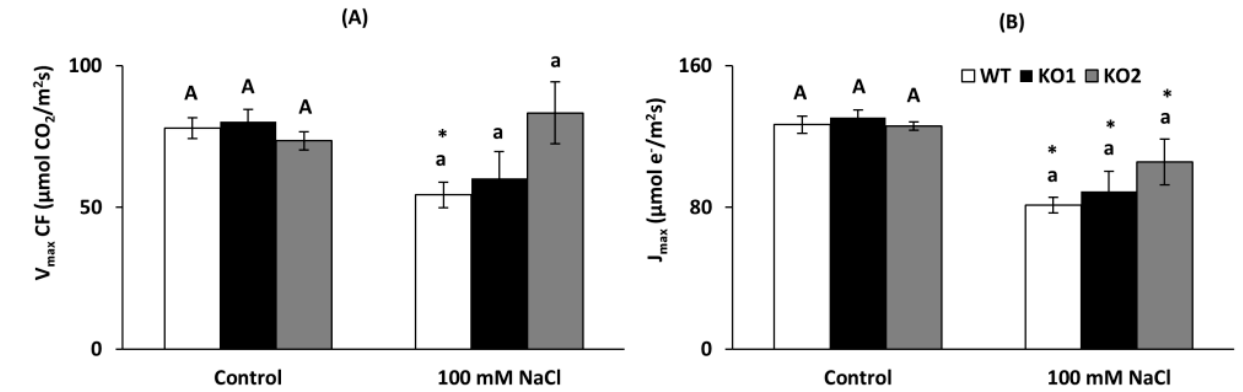
Figure 10. Photosynthetic parameters in leaves of A. thaliana wild type (WT) and two KO Attrxo1 mutant lines grown in the absence (Control) and presence of 100 mM of NaCl. ( A ) Maximum velocity of Rubisco carboxylation (V cmax ) and ( B ) maximum electron transport rate (J max ). Data are the mean ± SE of at least 9 replicates. Different letters indicate significant differences ( p < 0.05) among genotypes in each condition according to the Tukey’s test, and the asterisks indicate significant differences of each genotype in salinity compared to the control condition using the t -Student’s test ( p < 0.05).